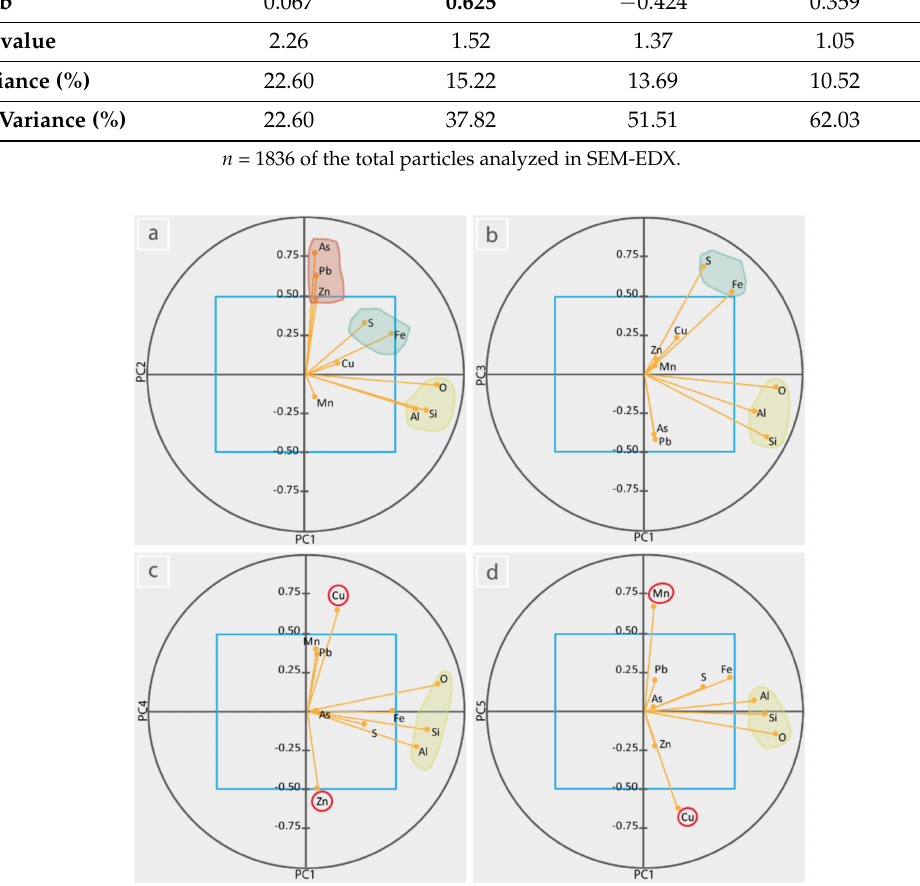
Figure 7. Representation of all the factorial plans and identification of group